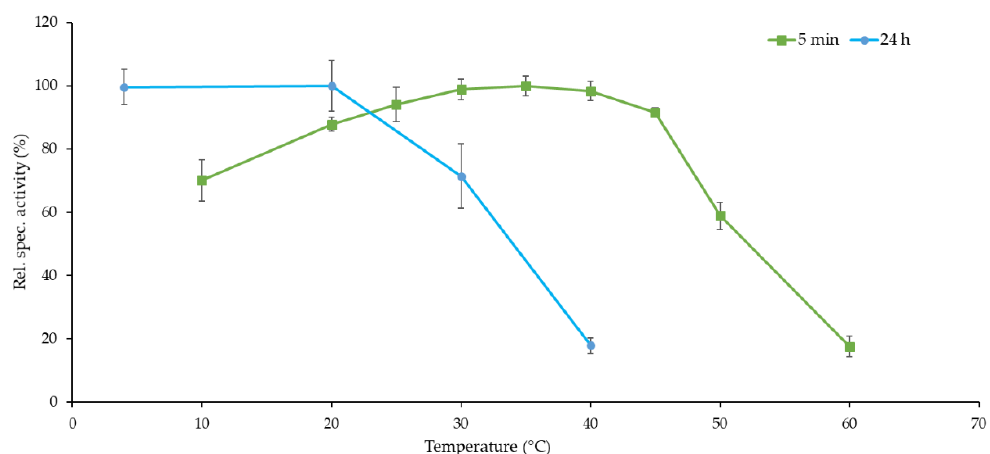
Figure 3. The temperature profile and the temperature stability of Ppo-Er1. For the temperature profile Ppo-Er1 was incubated for 5 min at different temperatures (10–60 °C) and directly measured for the conversion of substrate cyclohexenone (1 mM). For the temperature stability measurement, Ppo-Er1 was incubated at four different temperatures (4–40 °C) and measured after 24 h at 25 °C. The error bars show the standard deviation of triplicates. Relative specific activity corresponds 100% to an activity of 0.52 U/mg for cyclohexenone.